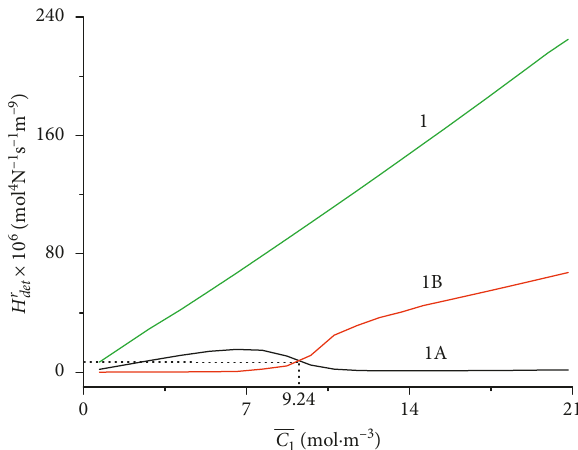
Figure 9: The graphic illustration of the dependence H r 3 ) ( r C A , B ) for the glucose in aqueous ethanol 2 (cid:31) 37.71mol · m (cid:31) solution in conditions of concentration polarization for configu- − rations A ( H A f ( C 1 , C 2 const.), curve 1A) and B ( H B det (cid:31) (cid:31) C 2 (cid:31) const.), curve 1B) of the membrane system. Line 1 illustrates f ( C 1 , C 2 const.) in conditions of homo- the dependence H det (cid:31) (cid:31) geneity of